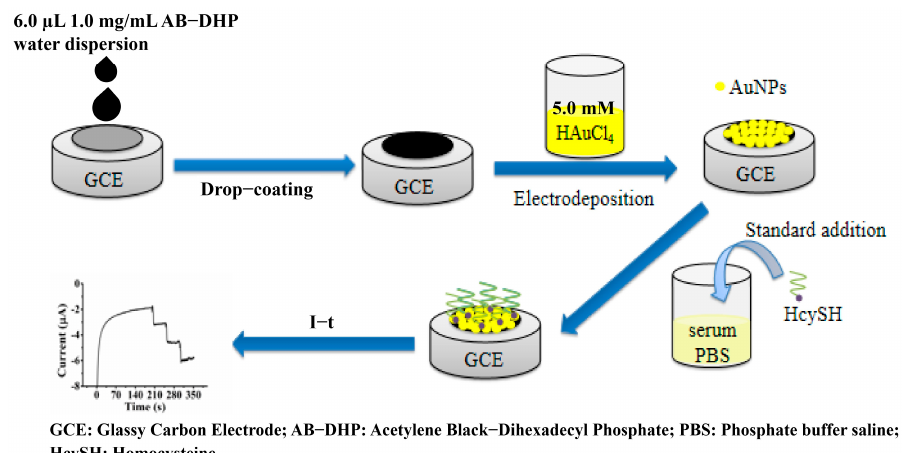
Figure 1. Diagram of the preparation process and application of the HcySH biomedical sensor.